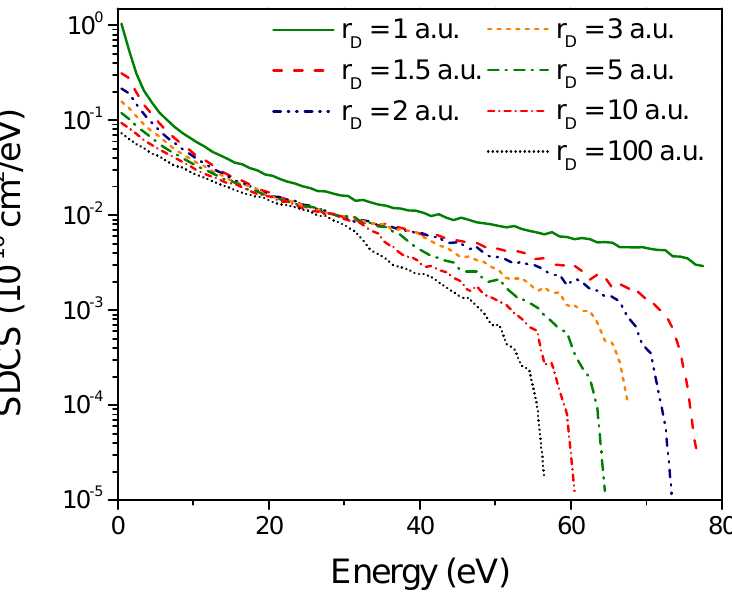
Figure 3. The CTMC singly differential cross section as a function of the emitted electron energy for different r D